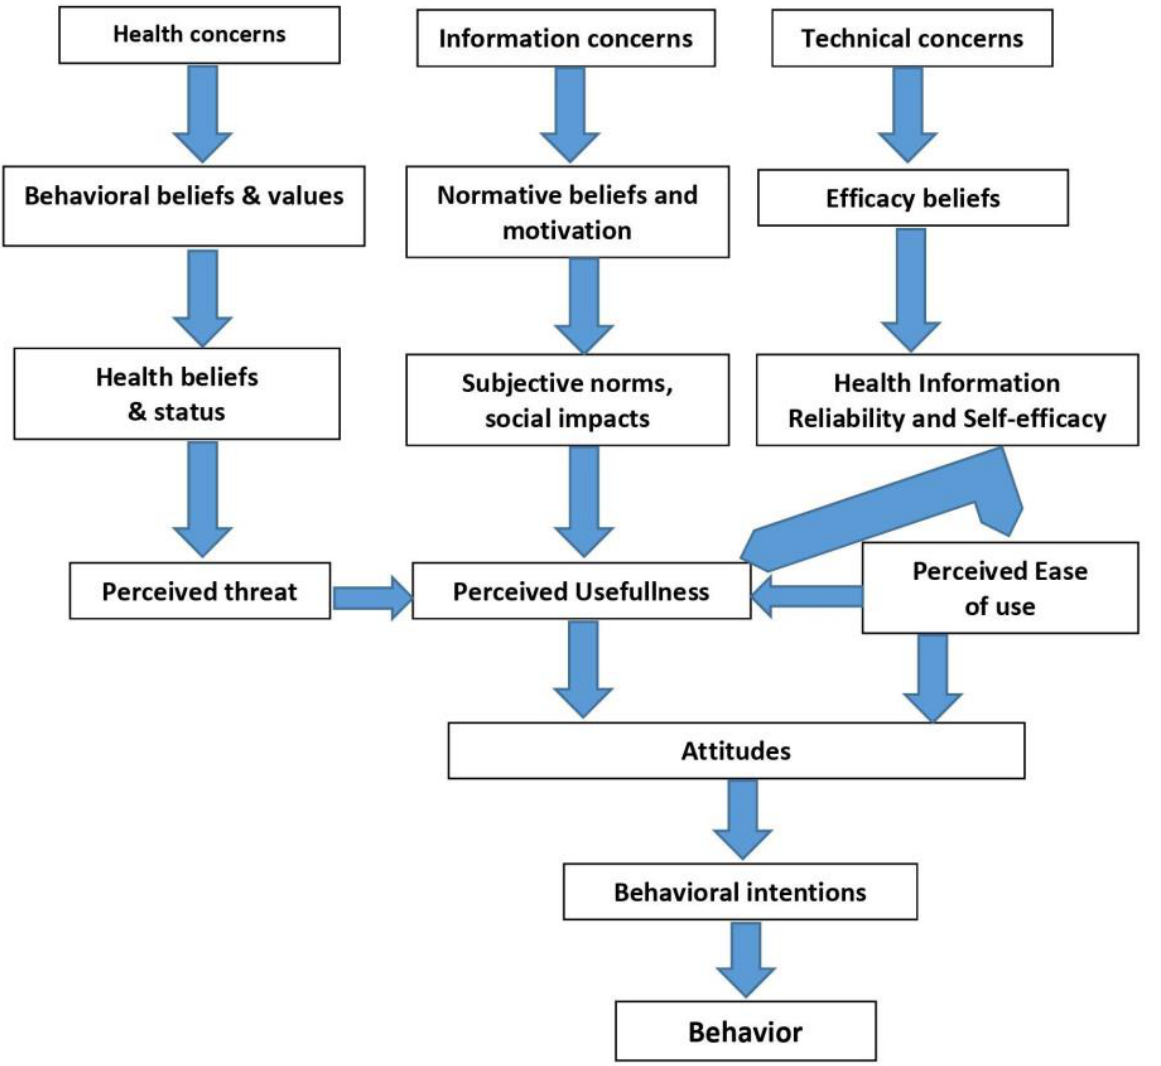
Figure 2. Health information technology acceptance model